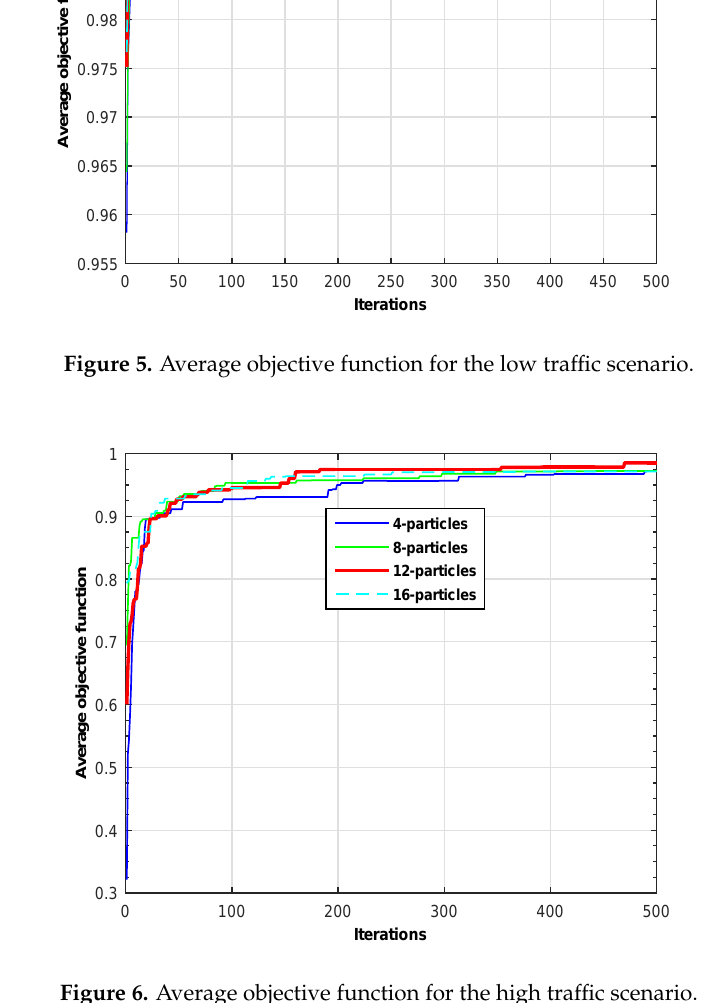
Figure 6. Average objective function for the high traffic